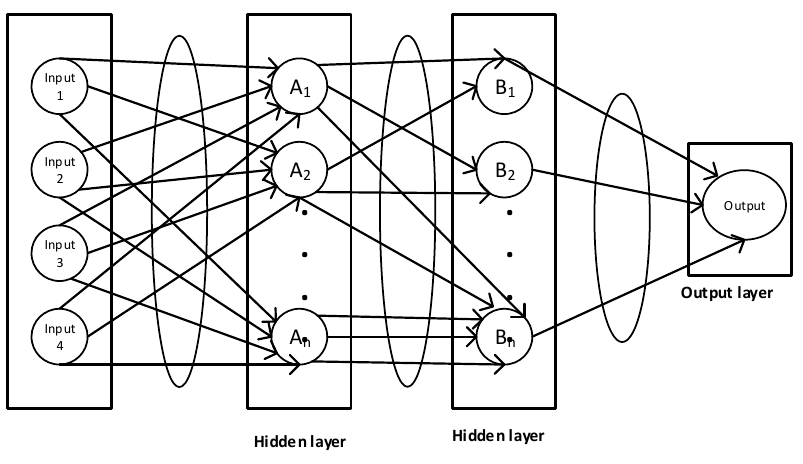
Figure 1. Radial basis architecture.